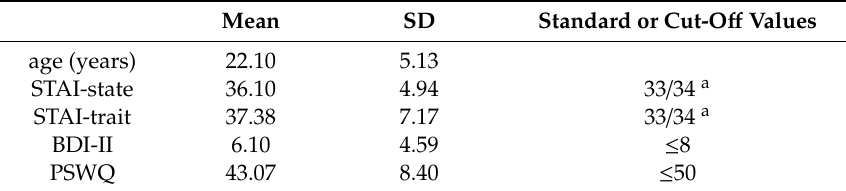
Table 1. Characteristics of